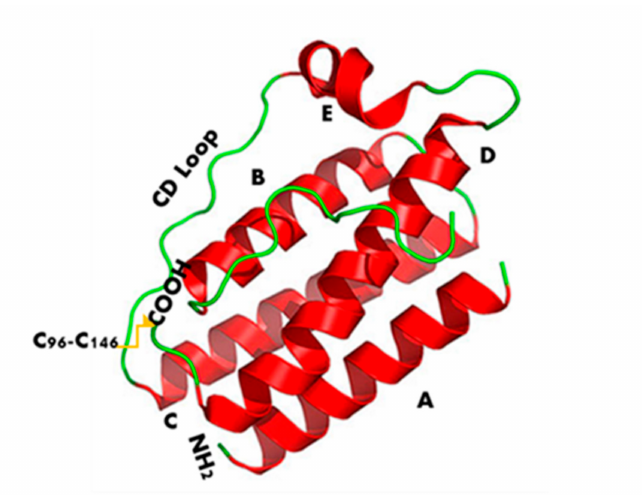
Figure 1. Leptin’s three-dimensional structure. It consists of four antiparallel α -helices (A, B, C, and D), connected by two long crossover links (AB and CD) and one short loop (BC), arranged in up-up-down-down helical bundle. A fifth helix E is contained in the CD